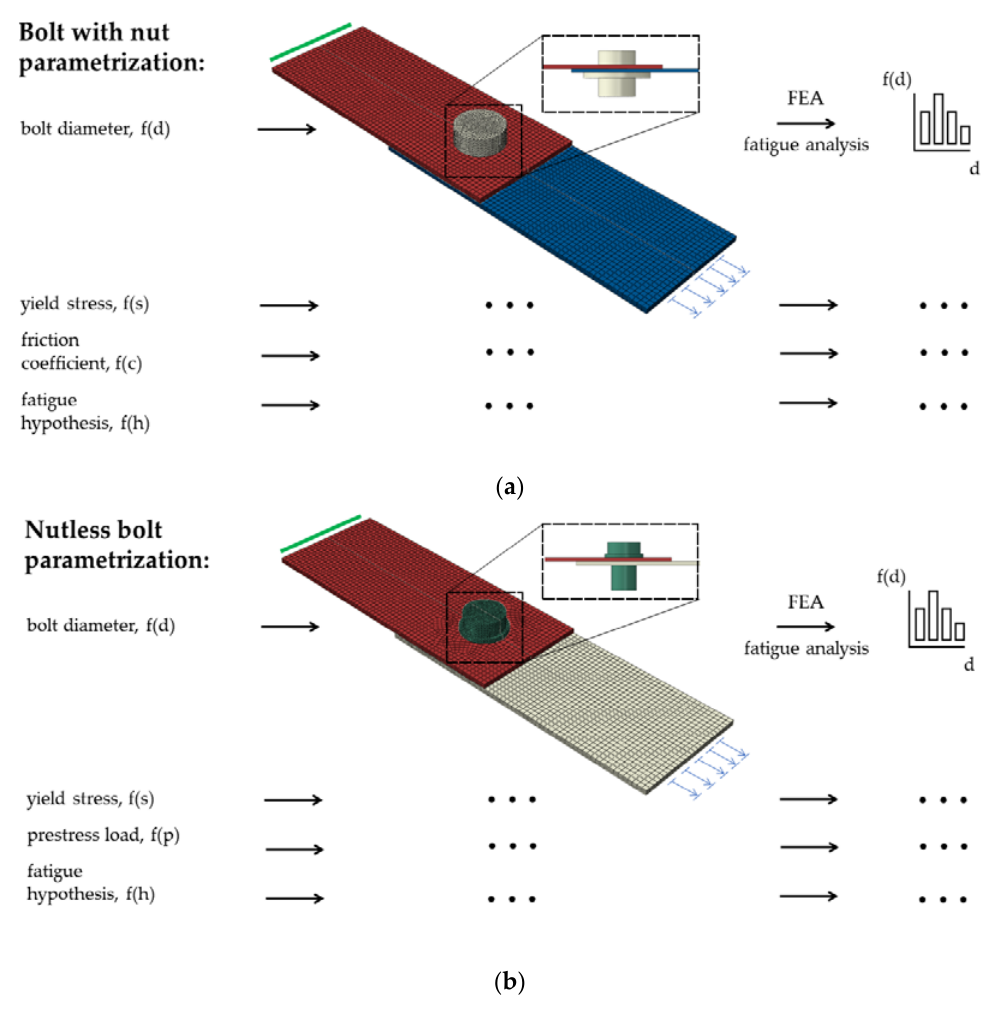
Figure 6. Schematic illustration of the fatigue study workflow: ( a ) parametrization for the bolt with a nut; ( b ) parametrization for the nutless bolt (schemes with the finite element meshes used).